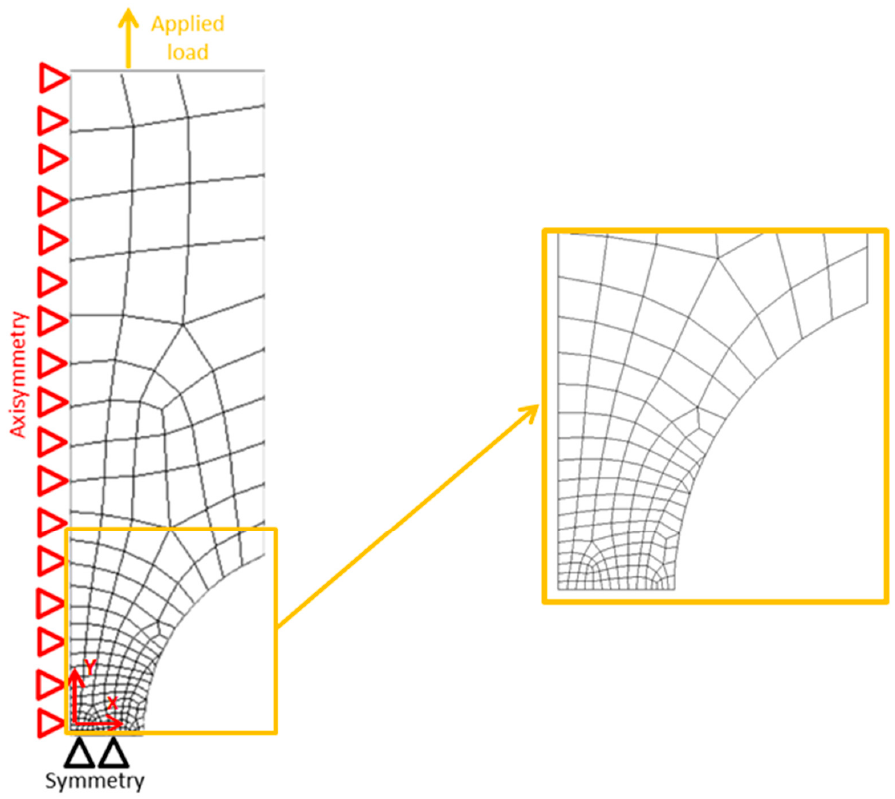
Figure 4. Typical mesh pattern of the finite element model near the notch tip and schematics of boundary conditions.